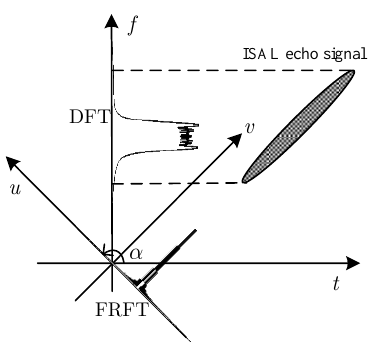
Figure 2. Schematic diagram of range compression via Discrete Fourier transform (DFT) and fractional Fourier transform (FRFT).